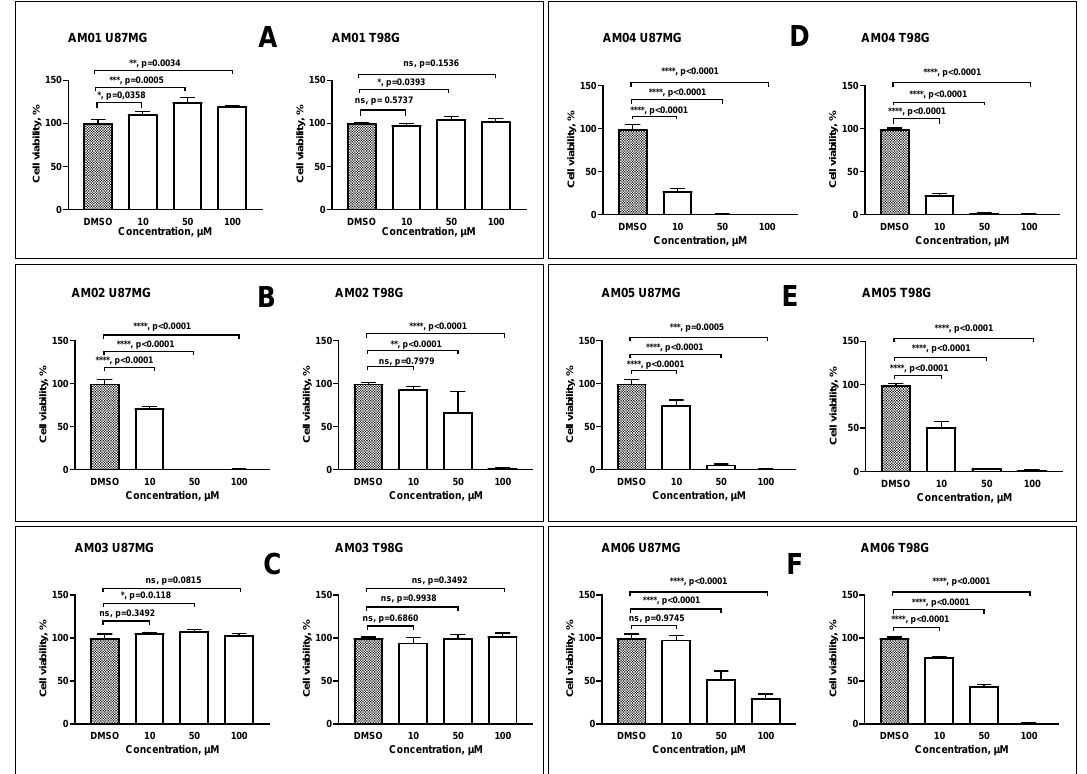
Figure 1. Proliferation analysis of human glioblastoma cell lines, U87MG and T98G treated with different sesquiterpene lactones. ( A ) AM01: 4 β ,5-dihydro-15- deoxy-eremantholide (MW 348); ( B ) AM02: 4 β ,5-dihydro-2 (cid:48) ,3 (cid:48) -epoxy-15-deoxy-goyazensolide (MW 362); ( C ) AM03: 4 β ,5-dihydro- 1 (cid:48) ,2 (cid:48) -epoxy-15-deoxy-eremantholide (MW 364); ( D ) AM04: goyazensolide (MW 360); ( E ) AM05: lychnofolide (MW 358) and ( F ) AM06: 15-deoxy-goyazenolide (MW 344). GBM cells were treated with dimethyl sulfoxide (1% DMSO, control), 10, 50 and 100 µ M of each drug. Data were represented as mean ± SEM, n = 3. For comparative analysis of groups of data one-way ANOVA was used, followed by Dunnett’s multiple comparisons test, performed using GraphPad Prism version 8.0.2 for Windows (GraphPad Software, San Diego, California USA, www.graphpad.com). The p values are presented in the figure. ns: not significant, p ≥ 0.05; *: significant, p values range between 0.01 to 0.05; **: very significant, p values range between 0.001 to 0.01; ***: extremely significant, p values range between 0.0001 to 0.001, and ****: extremely significant <